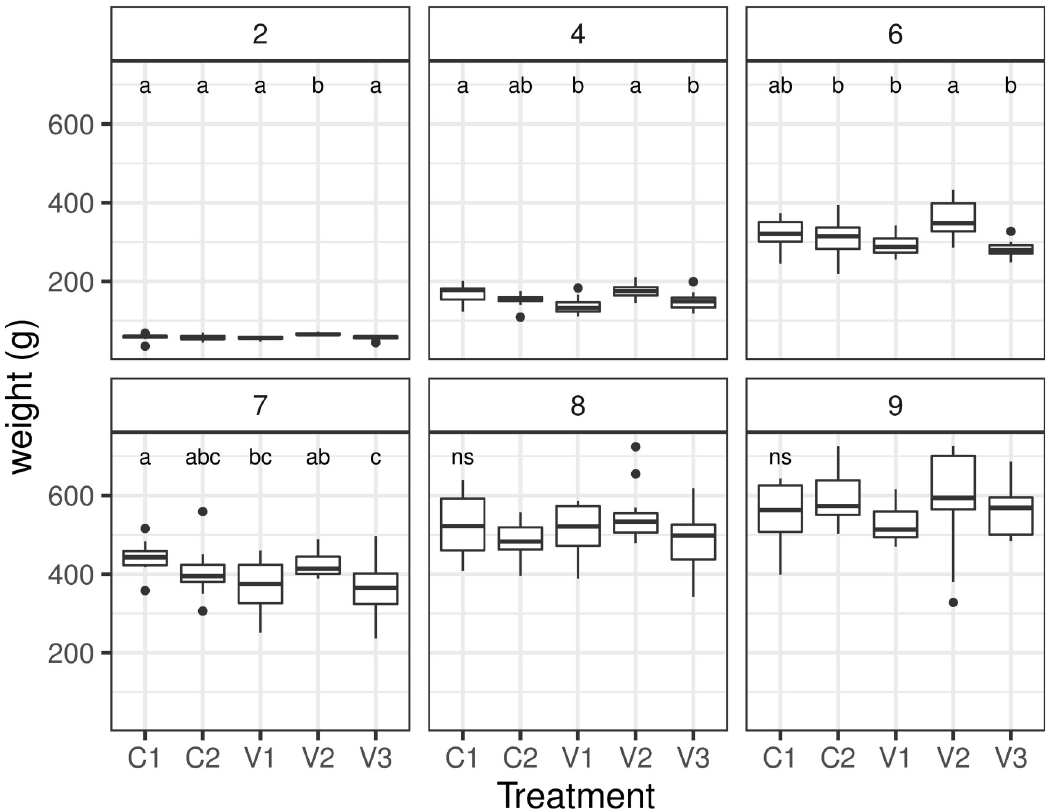
Fig 1. Weight development of the chick groups over the 9 weeks of the study. Small letters indicate significant differences between groups within weeks with 2,4,6,7,8,9 indicating the age of the chickens in weeks.